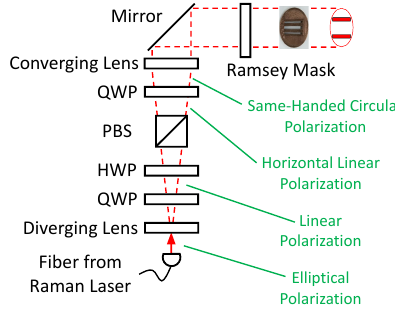
Figure 9. Depiction of the optics used to create the separate physical Raman beams from the single Raman laser. The beam size is manipulated so that a mask may be used to make the beams; as an example, this depiction shows a three-beam mask used for spin-echo interference. The polarization produced depends upon whether the configuration is Doppler-sensitive or not (this depiction shows same-handed circular polarization for a Doppler-free, co-propagating